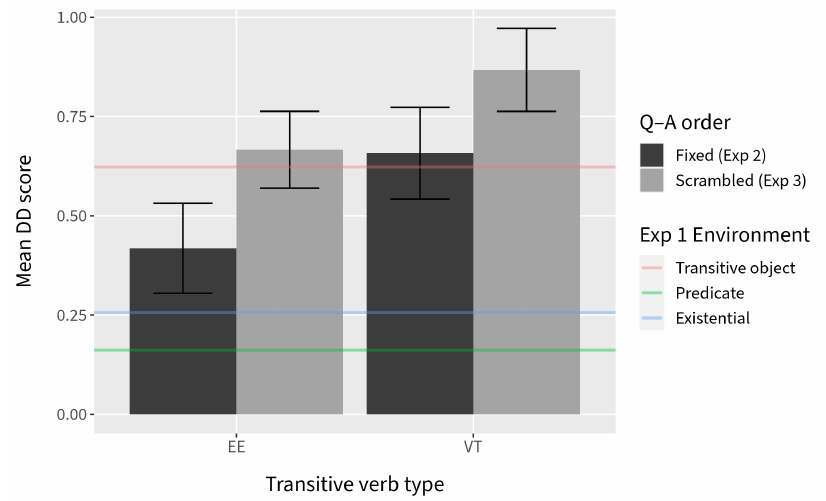
Figure 10. Average DD scores (calculated from z-scored ratings) by transitive verb type and Q–A order (Experiment) with Experiment 1 DD scores overlaid as horizontal lines. Error bars represent the standard error over DD scores. See z-scored ratings by item in Appendix